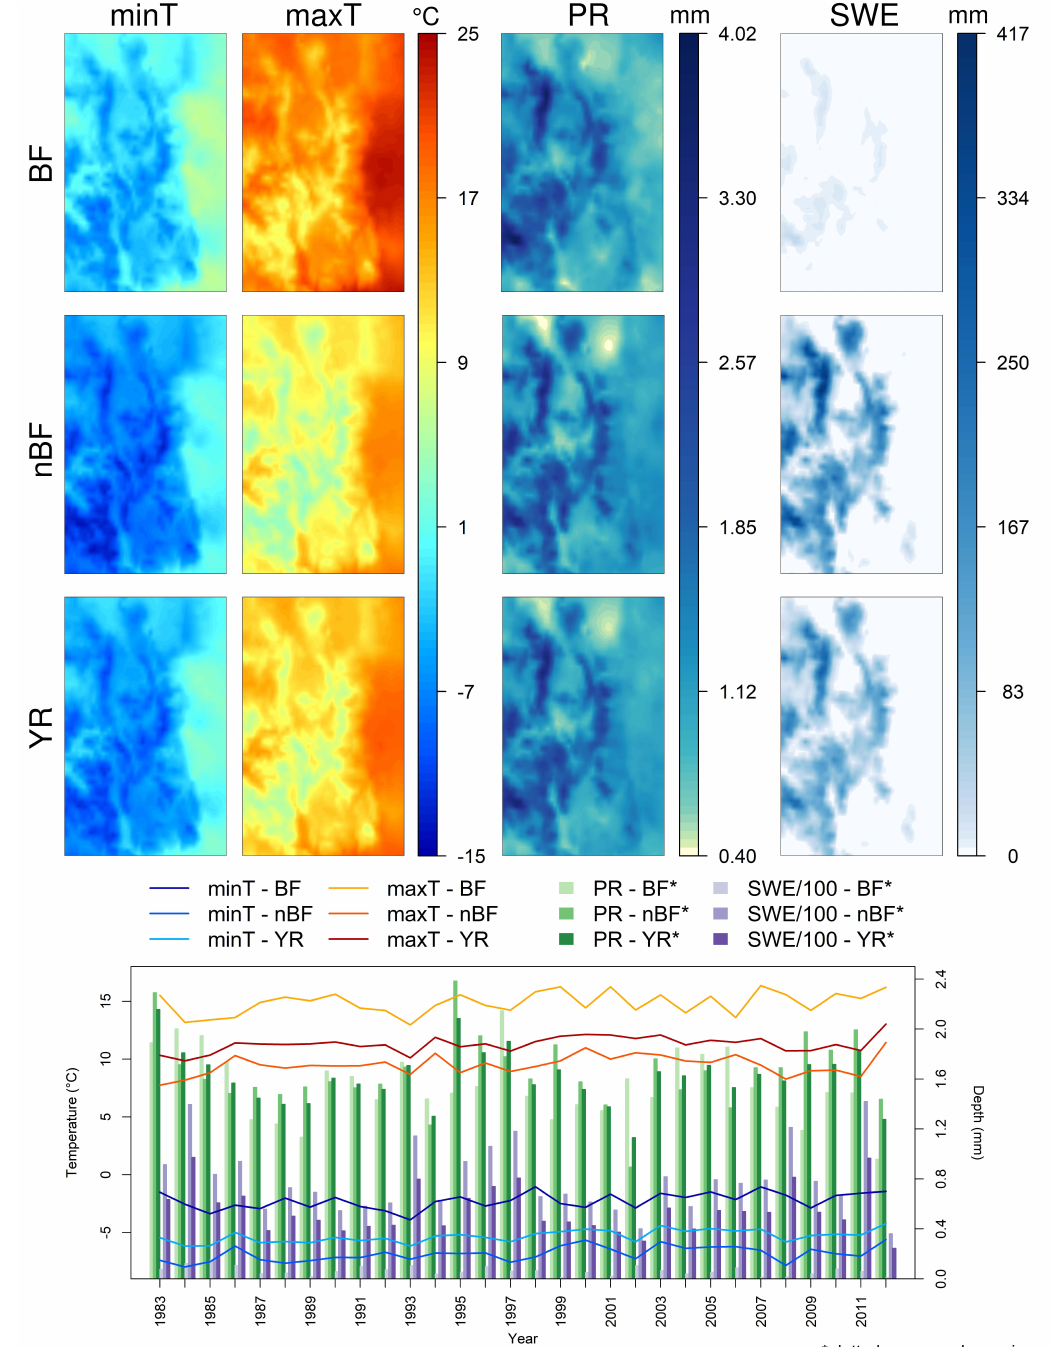
Figure A7. Minimum temperature (minT), maximum temperature (maxT), precipitation (PR), and SWE yearly averages for the cases including only base-flow months (BF), all other months (nBF), and all months of the year (YR). The top 12 panels present these averages for the year 2001 in the region of interest, while the bottom panel presents the evolution of the mean of these yearly averages in the stream network of interest for the period 1983–2012. SWE is scaled by two orders of magnitude in the bottom panel for visualization